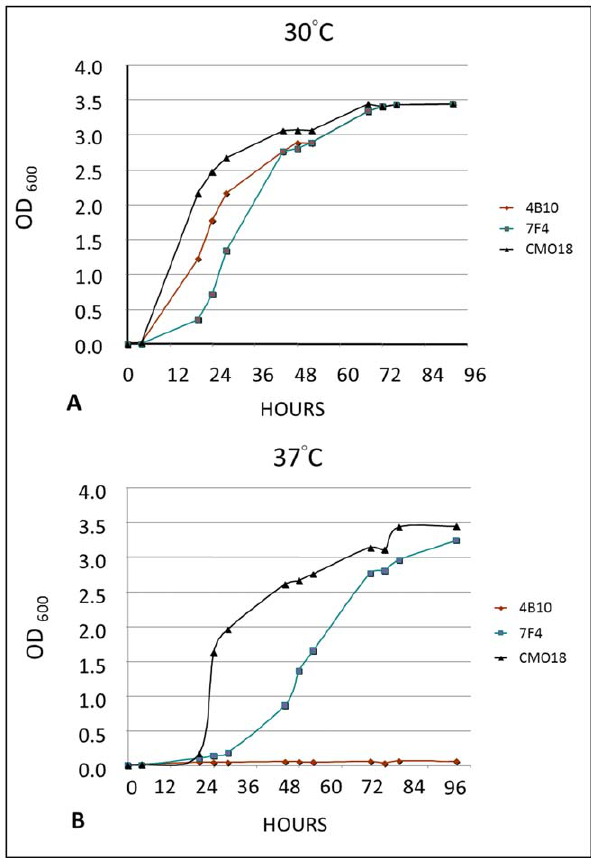
Figure 3. 30 u C and 37 u C growth curve. At 30 u C, 4B10 and 7F4 in shaking incubator showed reduced growth compared to parental strain. At 37 u C, 4B10 exhibited significant growth arrest whereas 7F4 exhibited a much slower growth than parental strain but reached